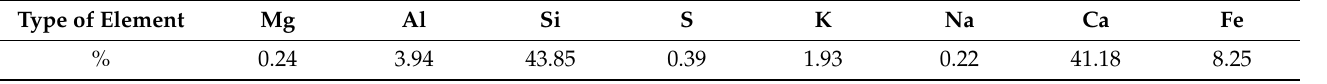
Table 2. Element compositions of the sample determined via X-ray